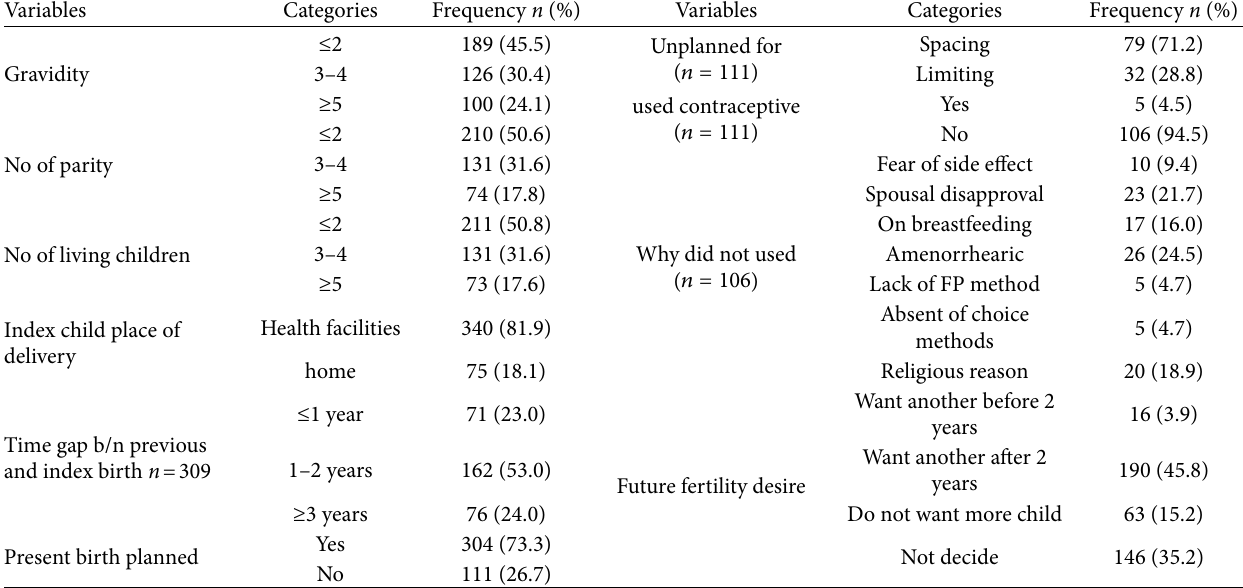
Table 2: Obstetric history of mothers, in Sekota town and its surroundings, Northwest, Ethiopia, 2017 (𝑛 = 415) .